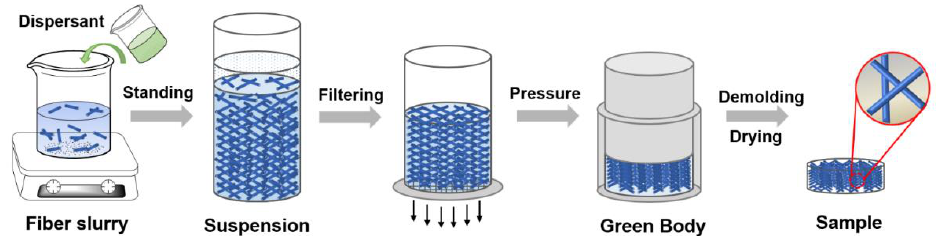
Figure 1. Fabrication process of SiO 2 fibrous porous materials.